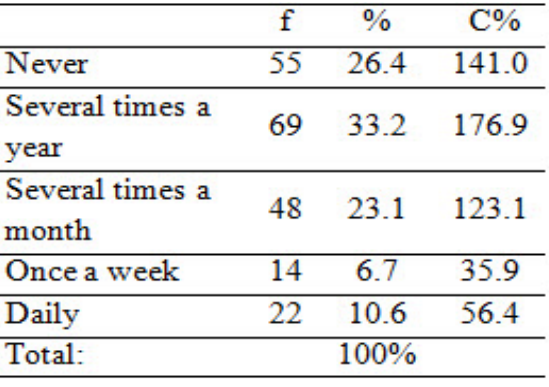
Table 2. Question 1: How often is